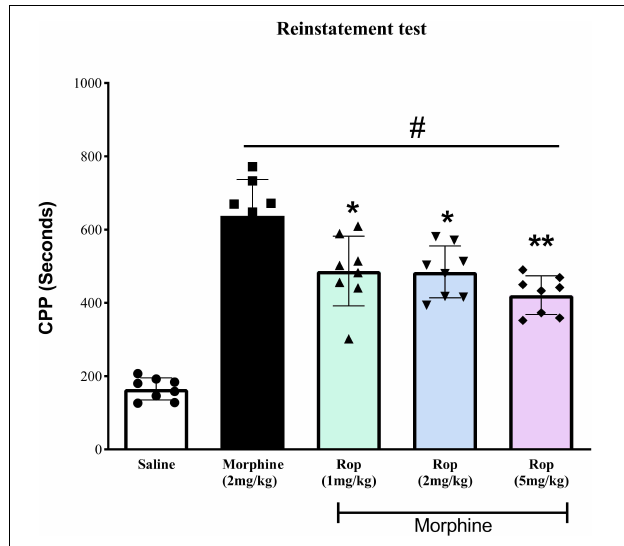
FIGURE 5 | The effect of ropinirole drug-priming reinstatement of morphine-induced CPP. After the last extinction test rats received different doses of ropinirole (1, 2, and 5 mg/kg) or saline 15 min prior to the priming injection of morphine (2 mg/kg) and were tested for the reinstatement of CPP. Results represent mean ± SD ( n = 8). # p < 0.001 compared with saline control group and * p < 0.01, ** p < 0.001 compared with the morphine group.